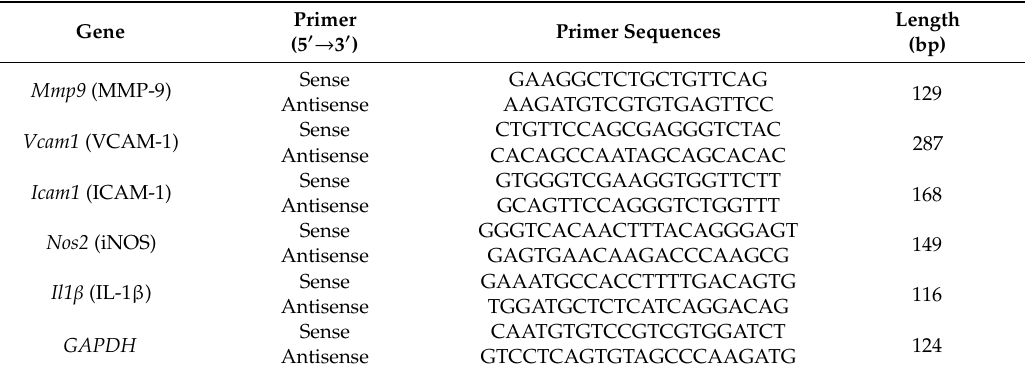
Table 1. The sequence of primer pairs for RT-PCR